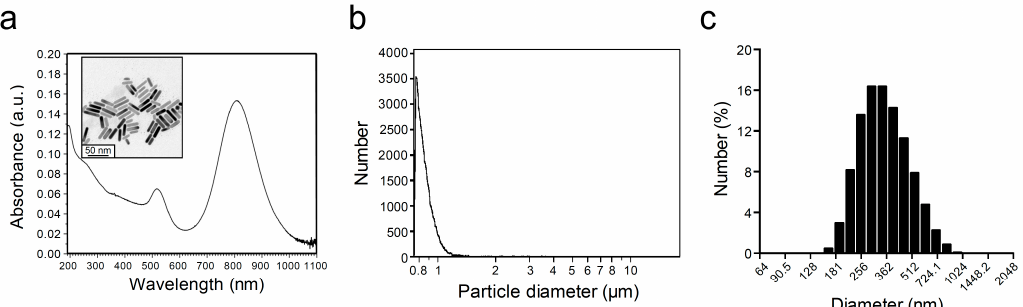
Figure 4. The size distribution of gold nanodroplets. ( a ) The spectrum map shows that the gold nanords (AuNRs) used for gold nanodroplet (AuND) synthesis has a peak optical absorbance wavelength at 808 nm. ( b , c ) The size distribution of AuNDs measured by using Multisizer and Zetasizer, respectively.